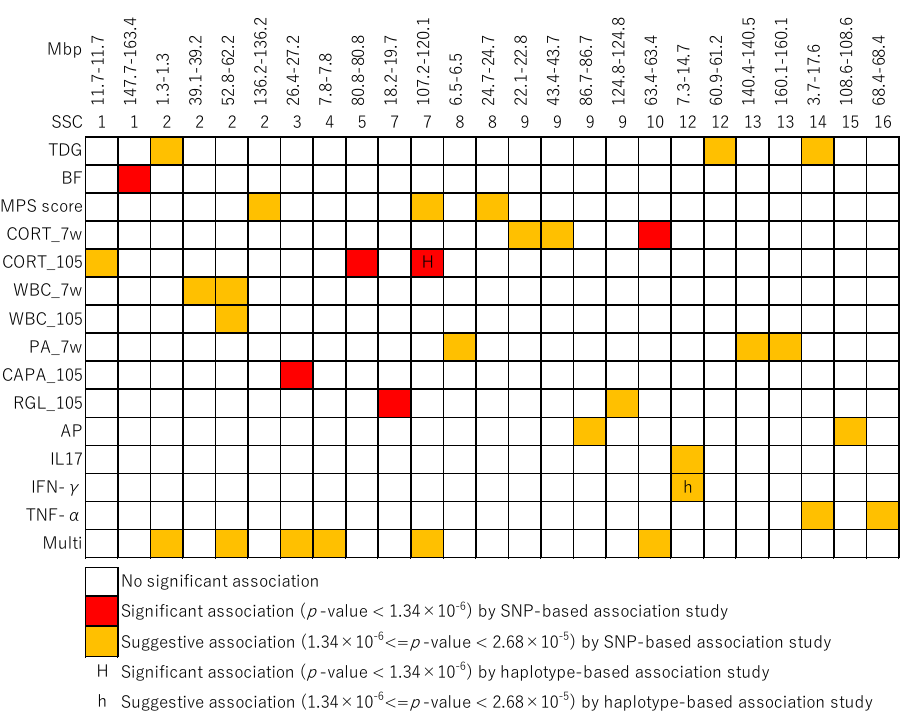
Figure 3. The summary regions associated with traits across genome. Each row represents the results of single nucleotide polymorphisms (SNPs)-based and haplotype-based genome-wide association studies (GWAS) in each trait. Each column represents a genomic region containing SNPs with suggestive and significant levels in each result. For the results of GWAS, and p- value = 2.68 × 10 –5 and p- value = 1.34 × 10 –6 were regarded as genome-wide suggestive and significant associations with a trait, respectively. Only traits with at least one associated SNP and SNPs associated with at least one trait are shown. Abbreviations of the traits are shown in Table